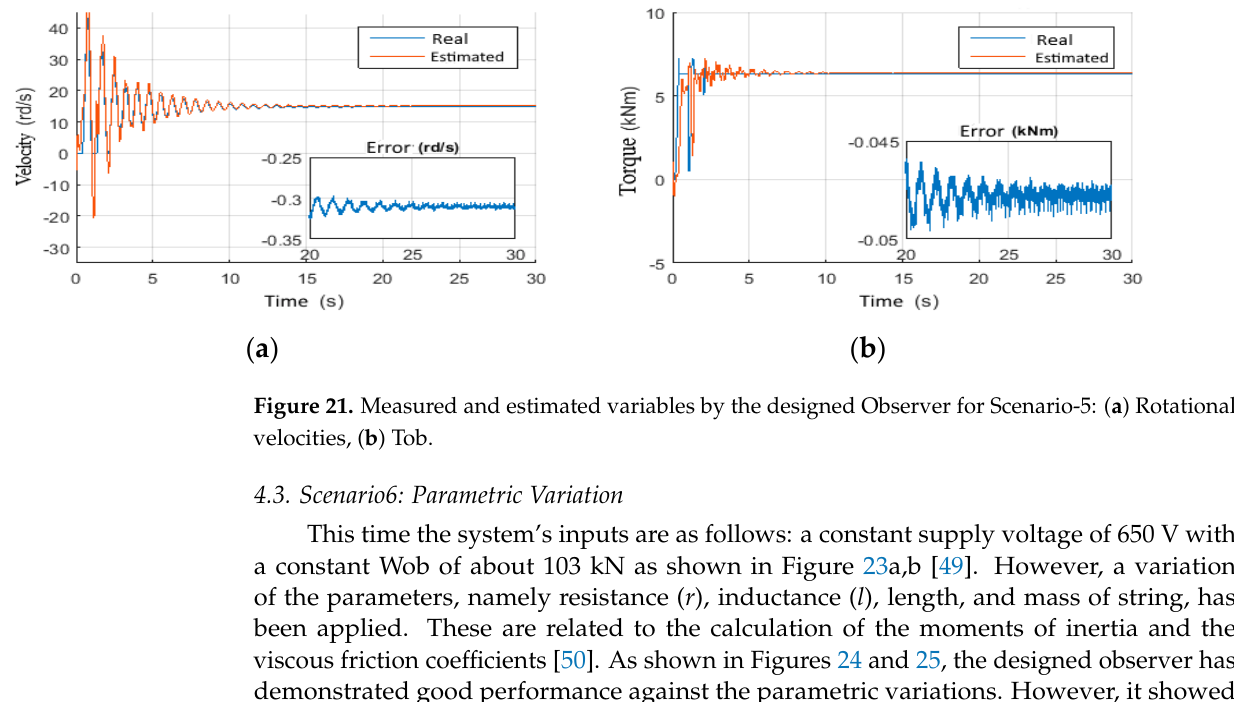
Figure 22. Measured and estimated variables by the designed Observer for Scenario-5: ( a ) Top-drive current, ( b ) Velocity. 4.3. Scenario6: Parametric Variation This time the system’s inputs are as follows: a constant supply voltage of 650 V with a constant Wob of about 103 kN as shown in Figure 23a,b [49]. However, a variation of the parameters, namely resistance ( r ), inductance ( l ), length, and mass of string, has been applied. These are related to the calculation of the moments of inertia and the viscous friction coefficients [50]. As shown in Figures 24 and 25, the designed observer has demonstrated good performance against the parametric variations. However, it showed sensitivity to the torque constant variation ( K ), as given in Figure 24b. The torque con- stant has a deviation of 3% from its nominal value [49].